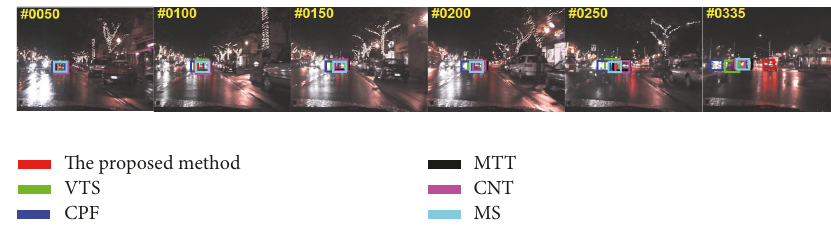
Figure 7: Qualitative evaluation about the tracker for sequences carDark seq.